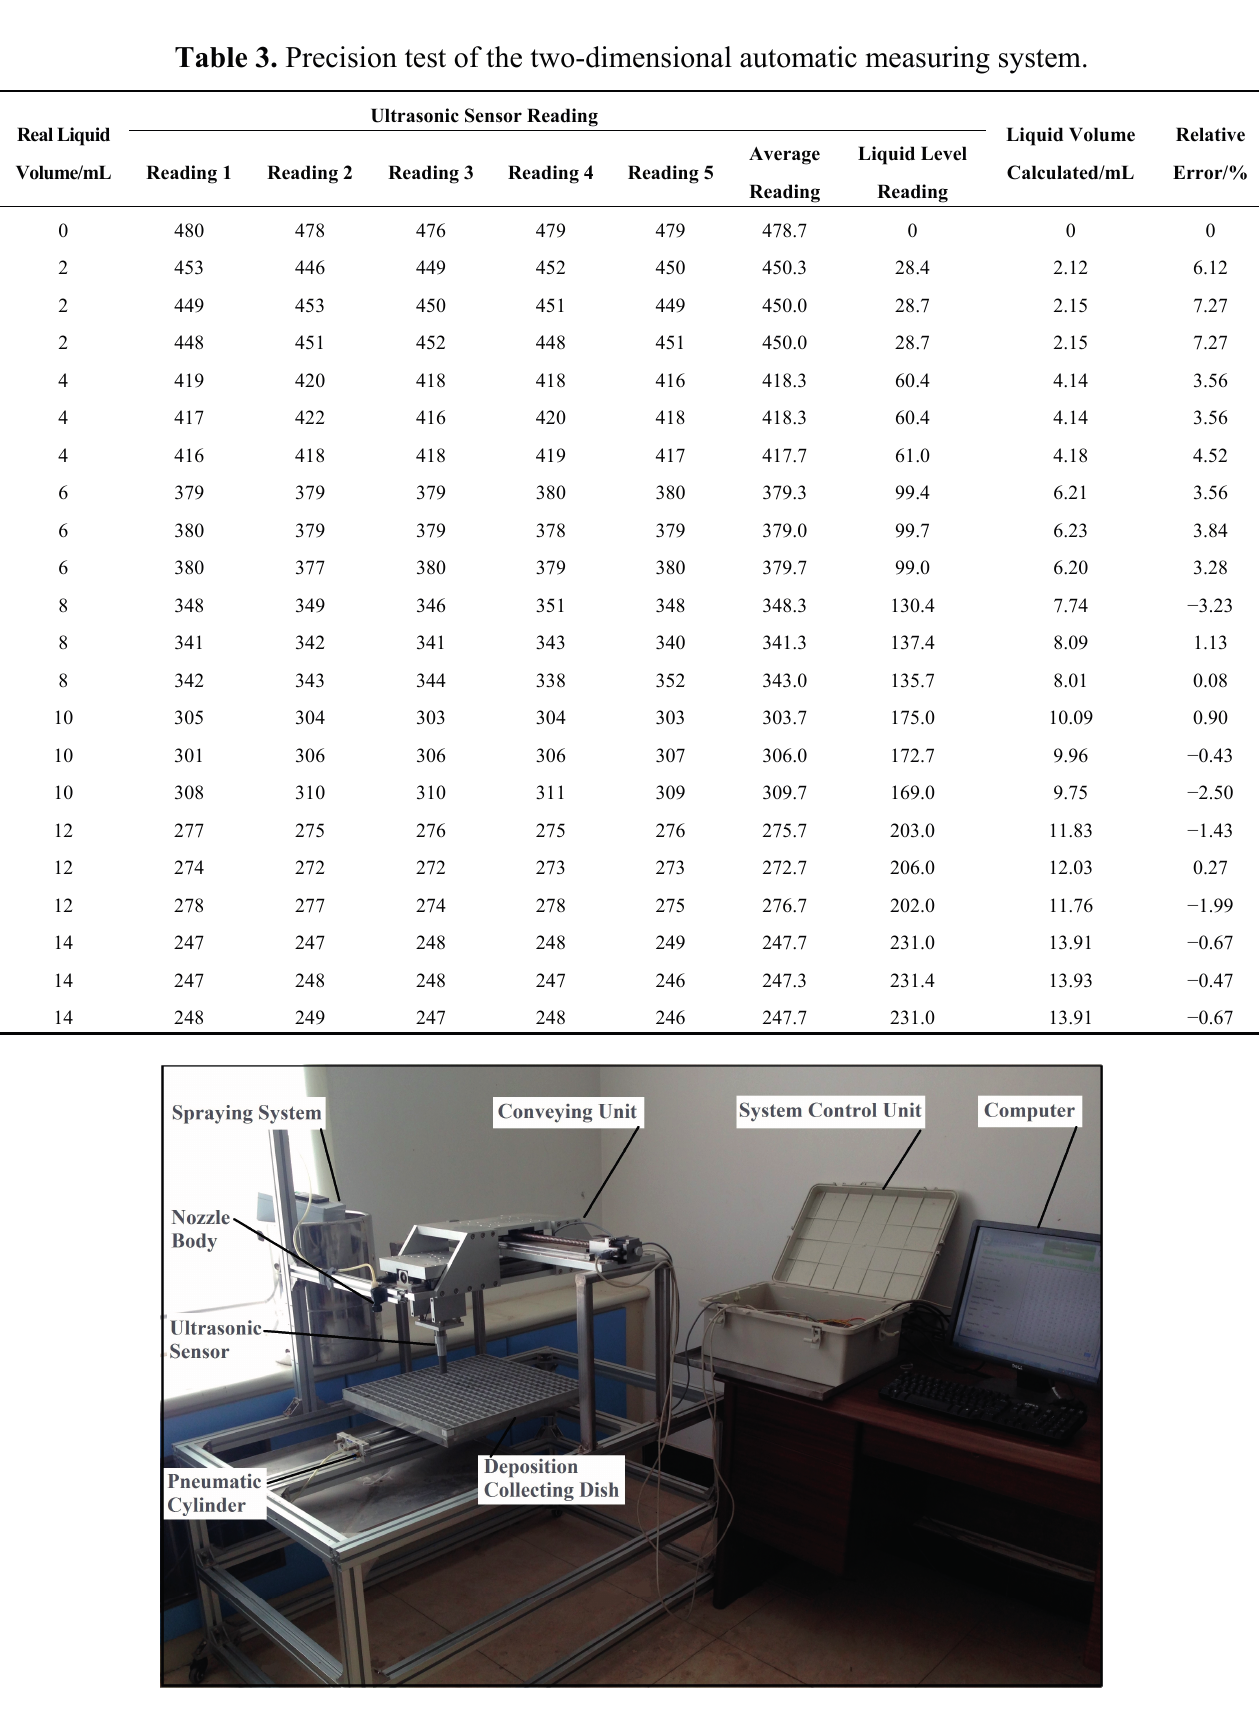
Figure 5. The developed two-dimensional automatic measuring system and a spraying